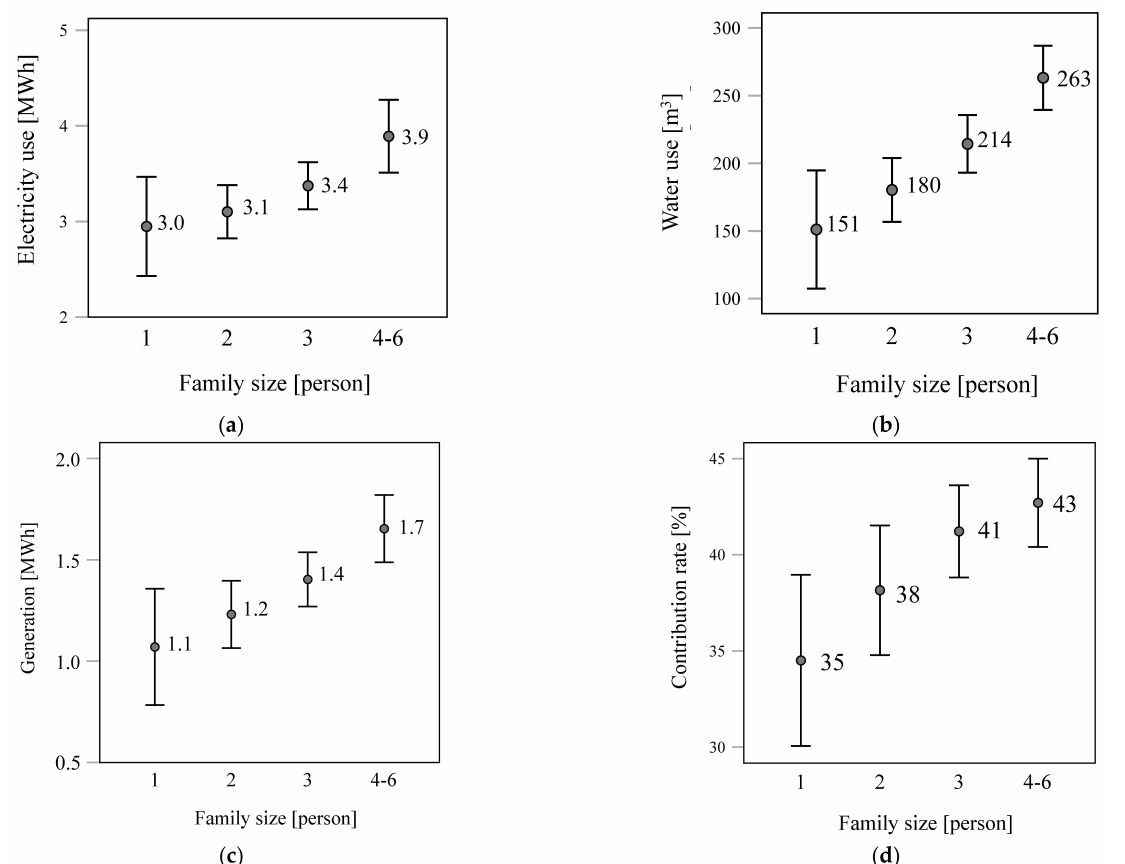
Figure 11. Variation by the family size (n = 161): ( a ) electricity use; ( b ) water use; ( c ) electricity generation by cogeneration system (CGS); ( d ) contribution